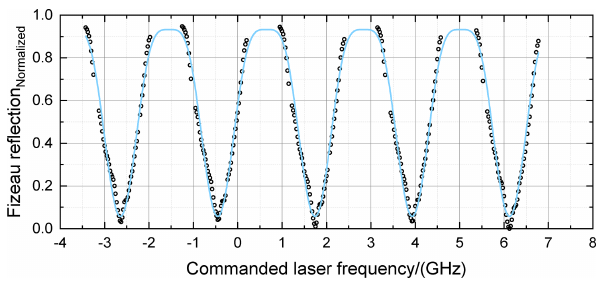
Figure 4. Normalized Fizeau reflection depending on commanded laser frequency obtained from an ISR measurement performed on 10 October 2018 (black dots) and the corresponding best fit of Eq. (10) (light-blue